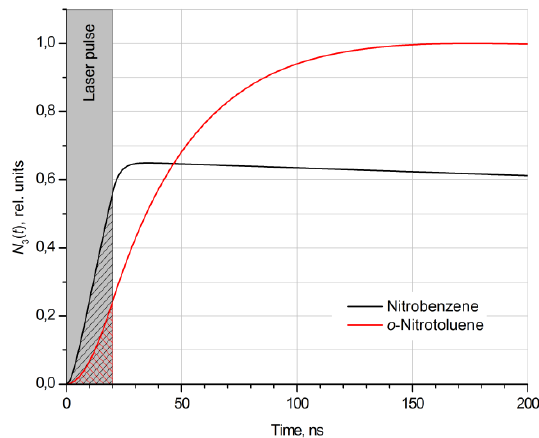
Figure 3. Time dependence of the normalized population of the second vibrational level (X 2 Π (v” = 2)) for NO fragments resulting from the laser pulse fragmentation of nitrobenzene and o -nitrotoluene molecules by a 20 ns rectangular laser pulse at an energy density of 10 mJ / cm 2 . The radiation wavelength is 248 nm.